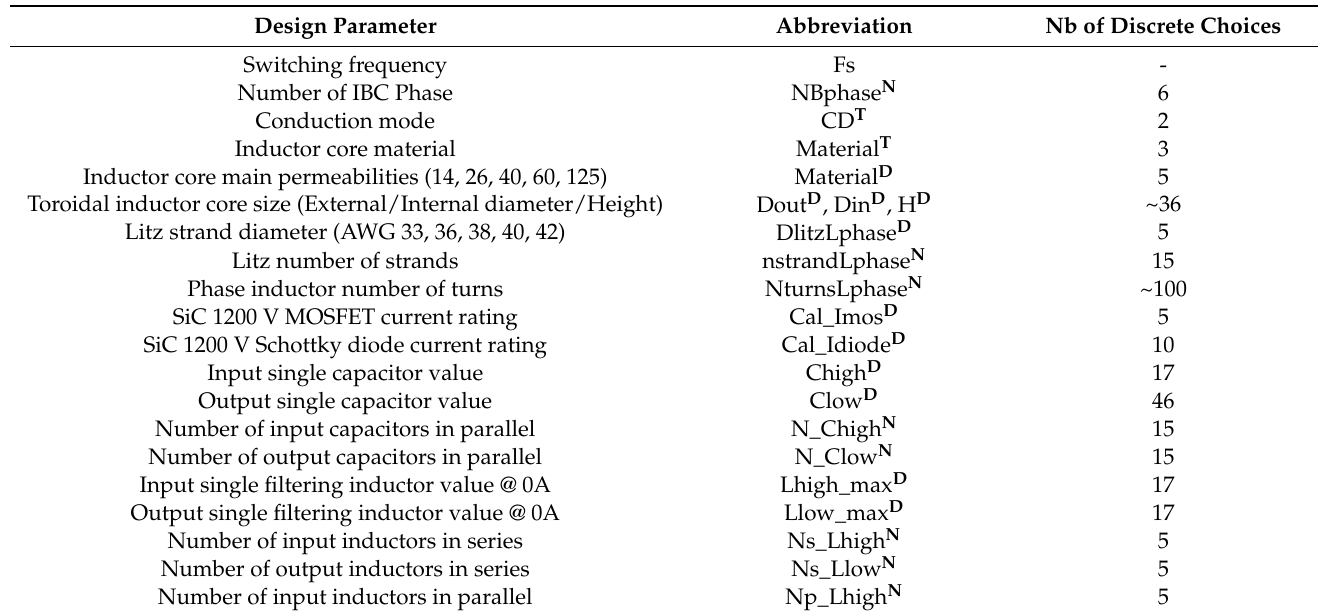
Table 2. IBC input design